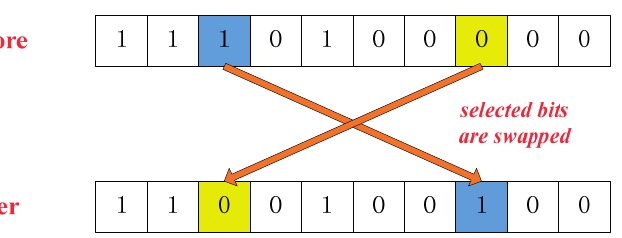
Figure 5. Mutation